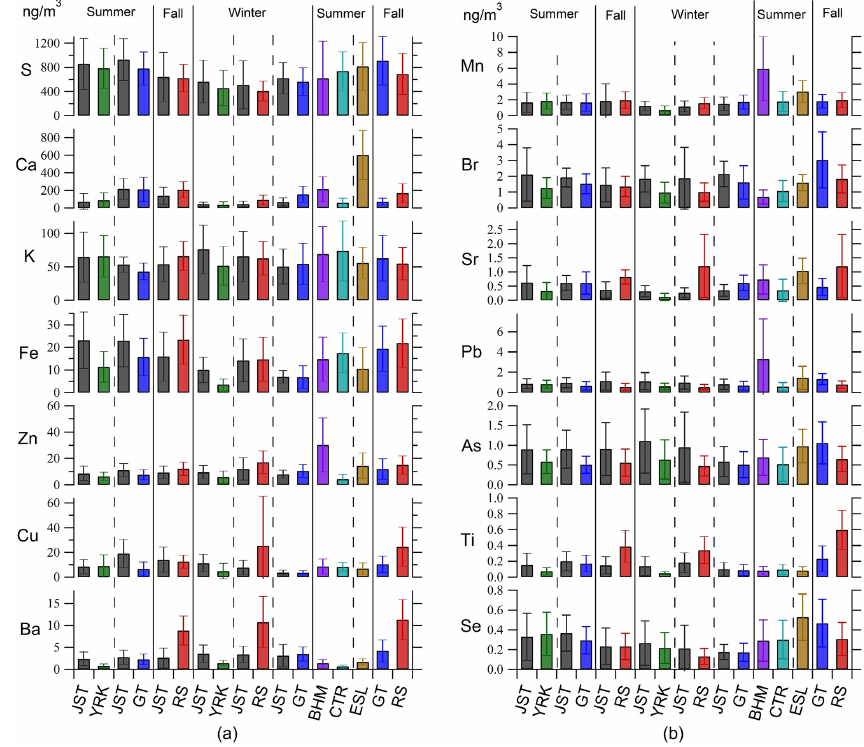
Figure 5. Monthly mean ( ± standard deviation) of water-soluble elements ambient concentration (ngm − 3 ) at various sampling sites. Seasons are separated by solid lines and simultaneous sampling at paired sites are separated by dashed lines (urban – JST, BHM, ESL; rural – YRK, CTR; near-road – GT; road-side –